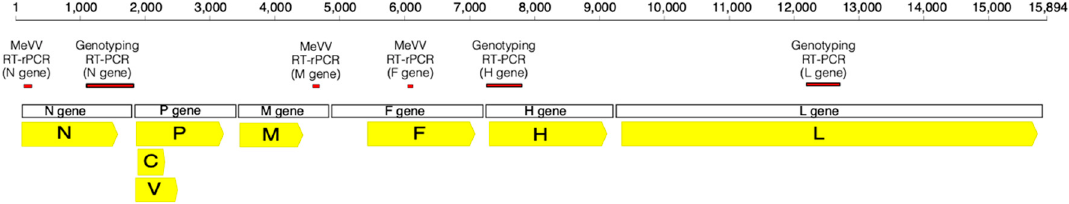
Figure 1. Schematic representation of the measles virus (MeV) genome highlighting the genes (open boxes), proteins produced (yellow arrows) and the diagnostic sequencing PCR assay targets (red boxes). The assays indicated are described in Table S1. The genome is drawn to scale and is based on